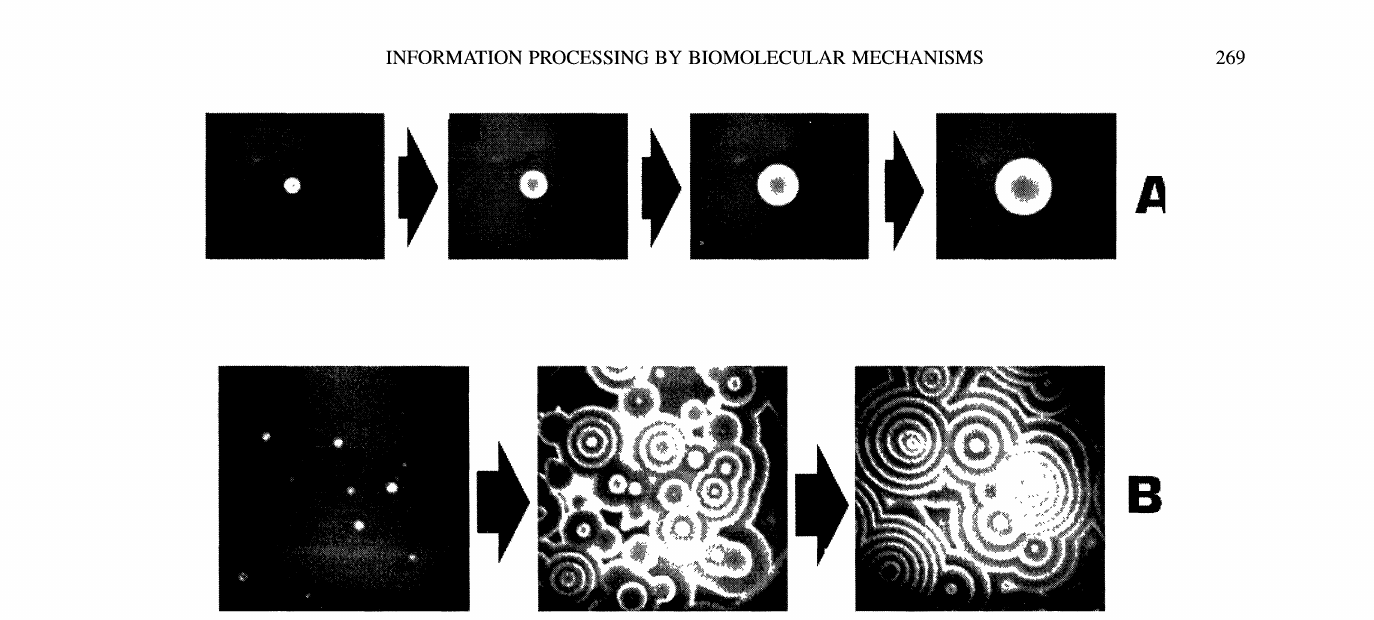
FIGURE Two modes of a Belousov-Zhabotinsky reaction in thin (pseudo-two-dimensional) layers of the reagent: (A) the process of trigger wave spreading corresponding to the switching of the medium from one stable state to another; (B) the emission of circular waves from point-wise sources and their further evolution. Here and in the following figures, gray arrows show steps of the image transformation by the reaction-diffusion medium, black arrows correspond to input of an initial image into